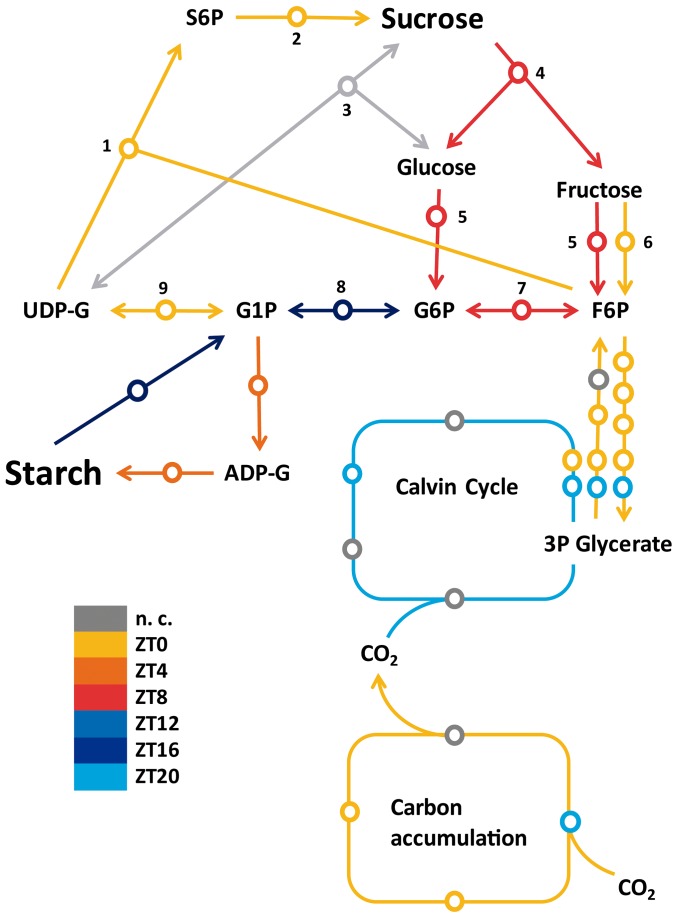
Temporal coordination of probes associated with sucrose and starch metabolism pathways.The time of peak of rhythms in transcript levels of genes associated with sucrose and starch metabolism was identified in a schematic metabolic pathway. Each circle corresponds to a specific gene model. Metabolic pathways were colored according to the median of the phase of their constitutive genes. The time of peak of probes associated with starch and sucrose synthesis pathways was between ZT20 and ZT4, while the time of the peak of probes associate to sucrose and starch degradation was between ZT8 to ZT16. Genes that were not circadian (n. c.) were in gray. Rhythmic with a time of peak at ZT0 are in yellow, ZT4 in dark orange, ZT8 in red, ZT12 in blue, ZT16 in dark blue and ZT20 in light blue. Enzymes for sucrose synthesis are: (1) sucrose-phosphate synthase; (2) sucrose phosphatase; (3) sucrose synthase; (4) neutral invertase; (5) hexokinase; (6) fructokinase; (7) glucose-6-phosphate isomerase; (8) phosphoglucomutase; (9) UDP-glucose pyrophosphorylase [75]. Abbreviations: S6P – sucrose 6-phosphate; UDP-G - UDP-glucose; G1P – glucose 1-phosphate; G6P – glucose 6-phosphate; F6P – fructose 6-phosphate; ADP-G – ADP-glucose; 3P glycerate – 3-phospho glycerate.